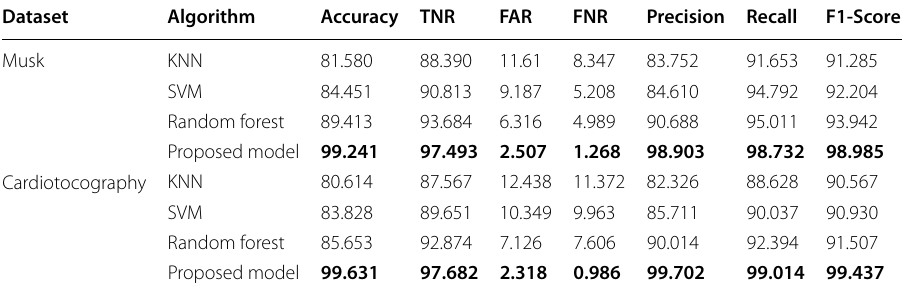
The highest scores are highlighted in bold